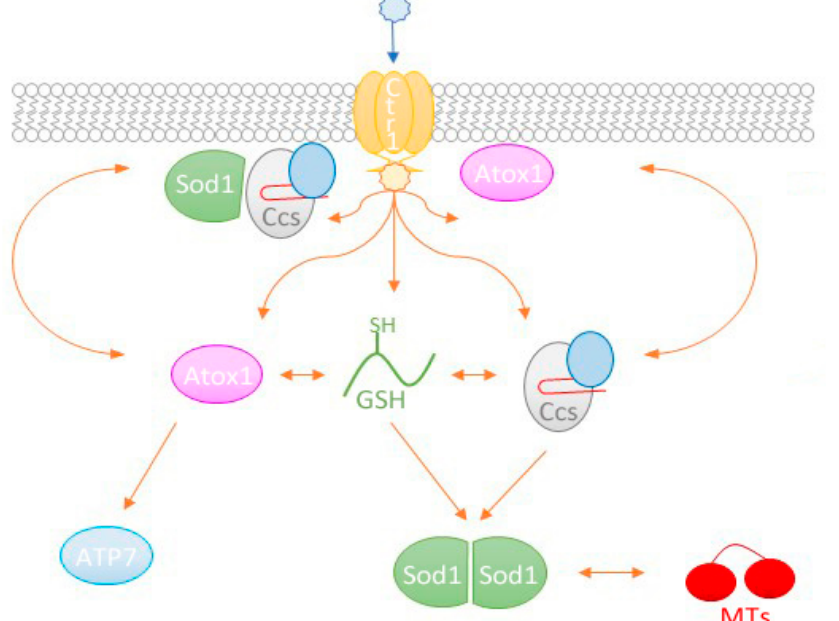
Figure 2. Potential routes of delivery between the copper importer Ctr1 and Sod1. Extracellular copper is commonly carried as Cu(II) (blue star) and must be reduced to Cu(I) (yellow star) for import by Ctr1. From here, the copper has numerous paths that can be taken based upon cellular conditions and availability of carrier molecules (orange arrows). Both Ccs and Atox1 have shown the propensity to associate with lipid bilayers, which may facilitate copper acquisition from Ctr1. Additionally, Atox1 and Ccs have been demonstrated to directly exchange copper with each other before delivery to their targets (ATP7A/B and Sod1, respectively). Past work in the field has also shown that the reduced form of glutathione (GSH) can act as a copper acceptor from Ctr1, exchange that copper with other copper chaperones while also delivering its copper cargo directly to immature Sod1. Further evidence has suggested that metallothioneins (MTs) may be able to exchange copper(s) with other copper-binding proteins, like Sod1, likely under conditions of oxidative stress. The colors of molecules and domains in this figure attempt to mimic those in Figure 1.